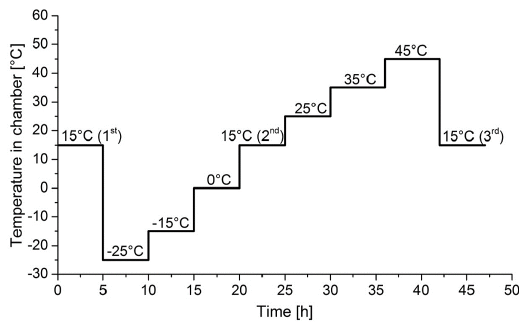
Figure 6. Applied temperatures for complex modulus Table 3. Calibration parameters for the 2S2P1D model for the tested materials at Tref=14.9 °C. Mixture